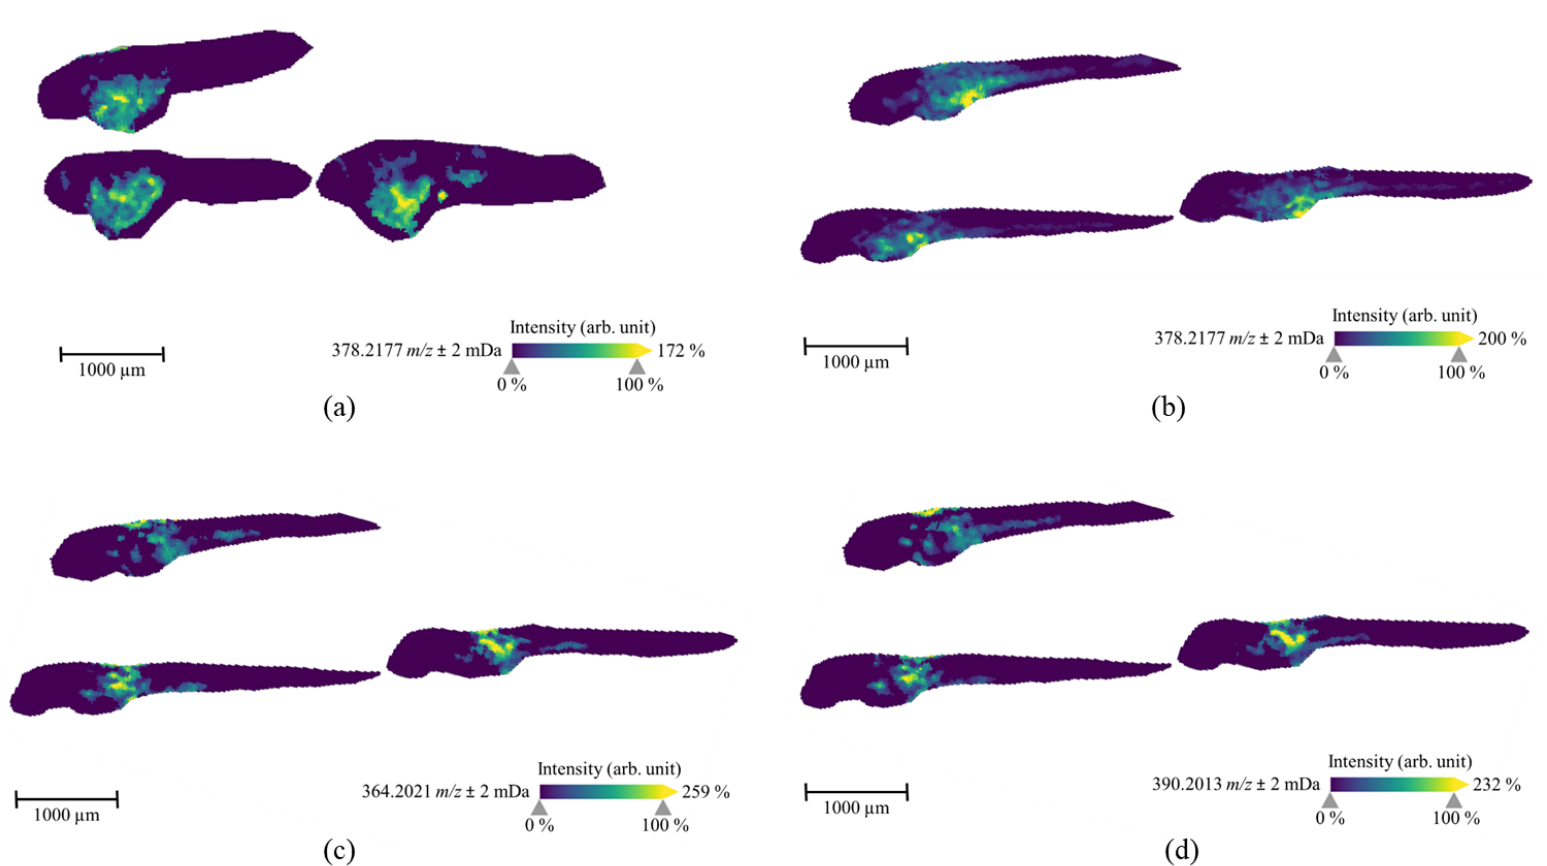
Figure 6. MALDI-MS images of the parent compound (7′ N -5F-ADB, m/z 378.2177) in ZF larvae that were treated by aquatic exposure with 50 µM 7′ N -5F-ADB for 1 d from 4 dpf to 5 dpf ( a ) or for 3 d from 2 dpf to 5 dpf ( b ). The MS images of two metabolites [M5, m / z 364.2021 ( c ) and M13, m / z 390.2013 ( d )] visualized in the slices of B specimen. These metabolites were detected as the most abundant masses in all ZF larvae exposed via various administration routes. The presented sections originate from one representative larva per condition. The images were generated by preparing a colormap from blue (no detection) to yellow (high local concentration), and images were further processed by weak denoising in 96 dpi resolution with 24-bit color.